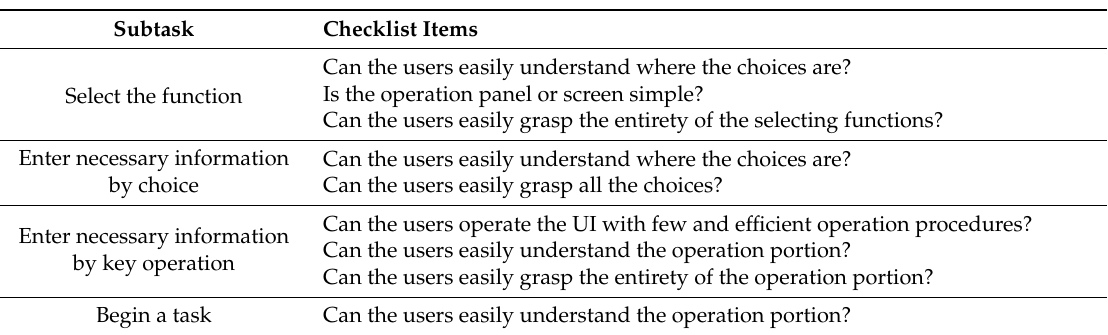
Table 4. Checklist items of pattern 2